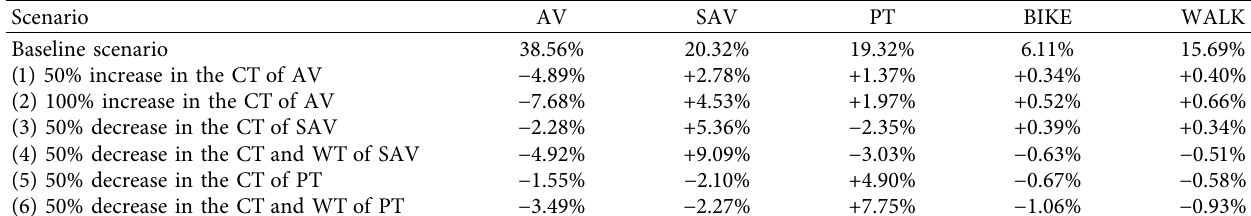
Table 8: Percentual demand changes in the scenarios (mandatory